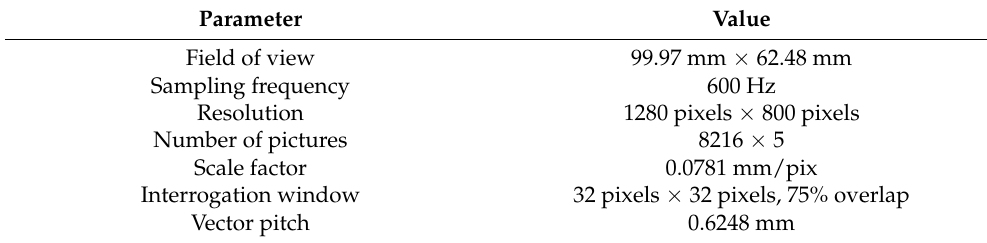
Table 1. Experimental